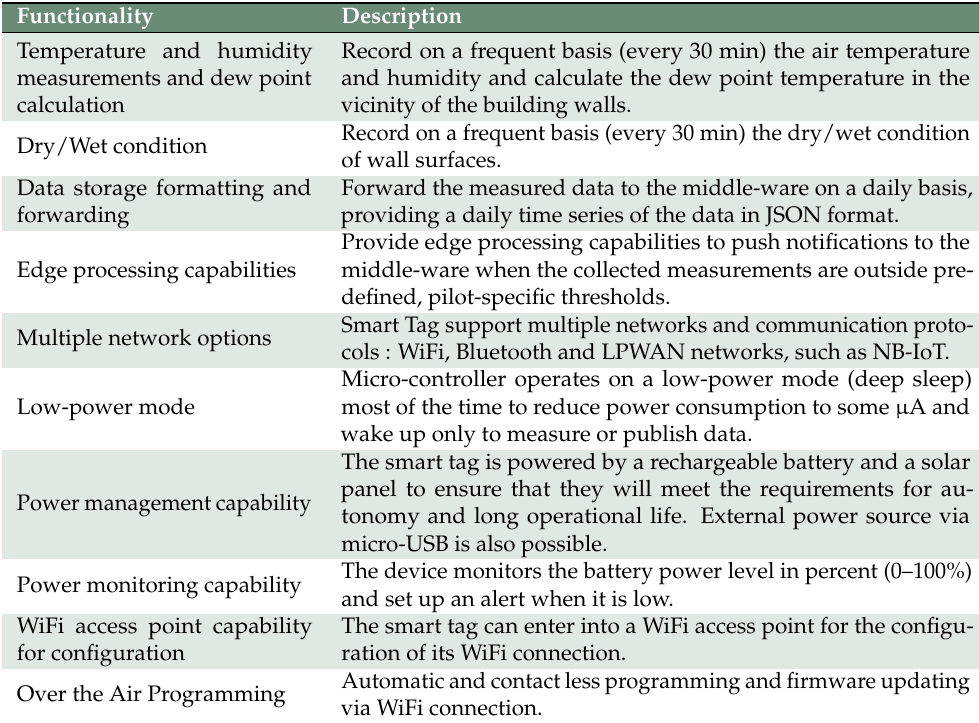
Table 2. The functionalities provided by the smart